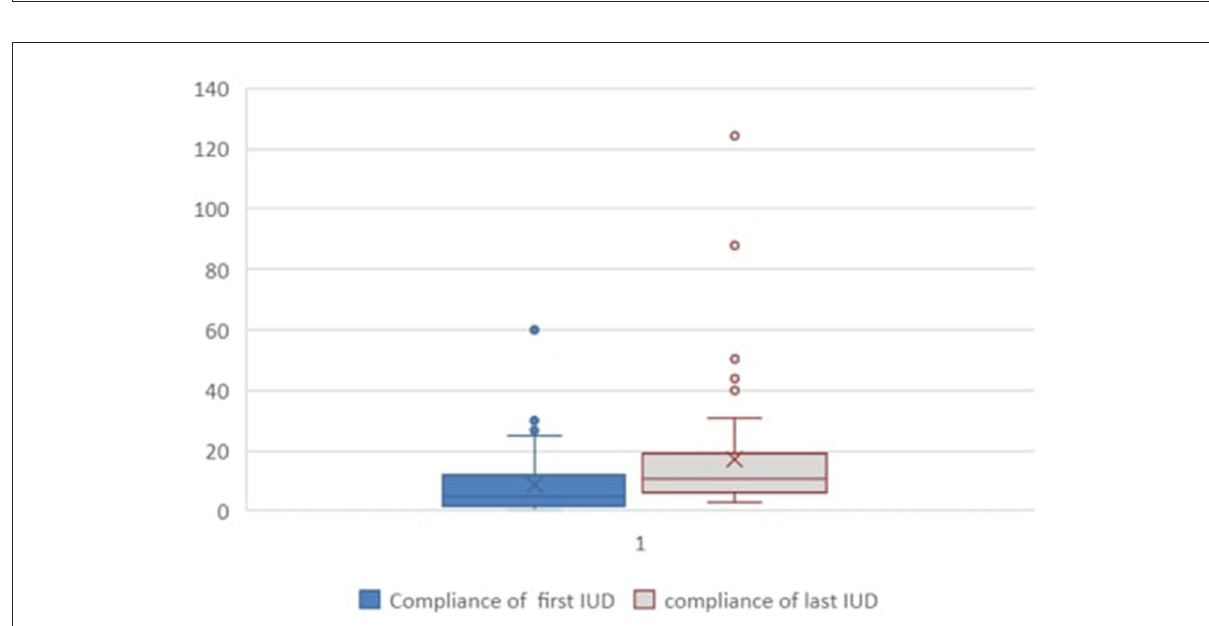
FIGURE2 Bladder compliance (mL/cm H 2 O) at first and last recorded IUDs. Fifty-four patients who had more than one test available were included. Statistical significance was assessed using paired t -test, and a p -value < 0.05 was considered significant. IUD, invasive video